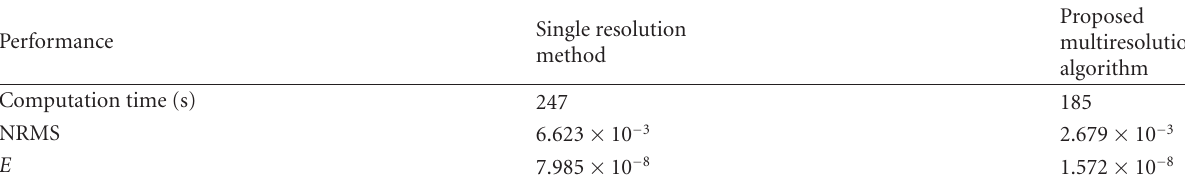
Table 3: Performance comparison of reconstruction algorithms.